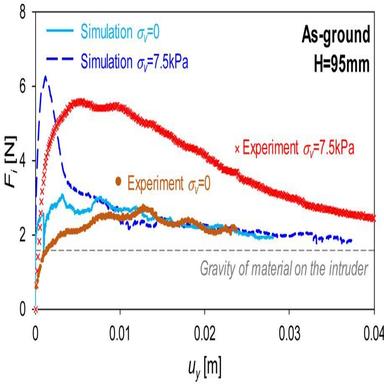
Comparison of time-lapse measured force on the intruder for the numerical simulation (lines) and physical experiments (dots). Fi denotes the intruding force and uy denotes the intruder travel distance. For clarity, Only the data of the as-ground sample with height H=95 mm with vertical pressures σ = 0 and 7.5 kPa are presented. The gray dashed line represents the force of gravity from the material that is directly above the intruder.